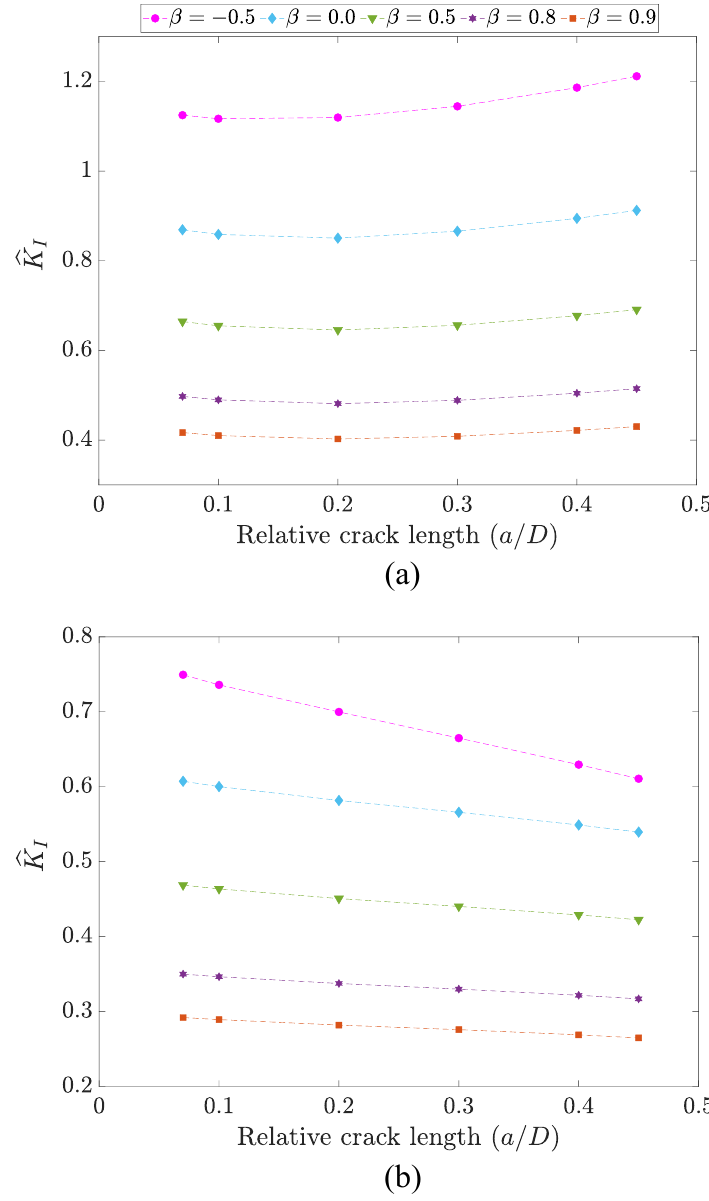
Figure 7. Comparison of non-dimensional stress intensity factor of an orthotropic fibre embedded in a matrix, for different fibre longitudinal/transverse stiffness ratios ( β ) at fibre–matrix stiffness ratios: ( a ) α = 0.95 and ( b ) α = −